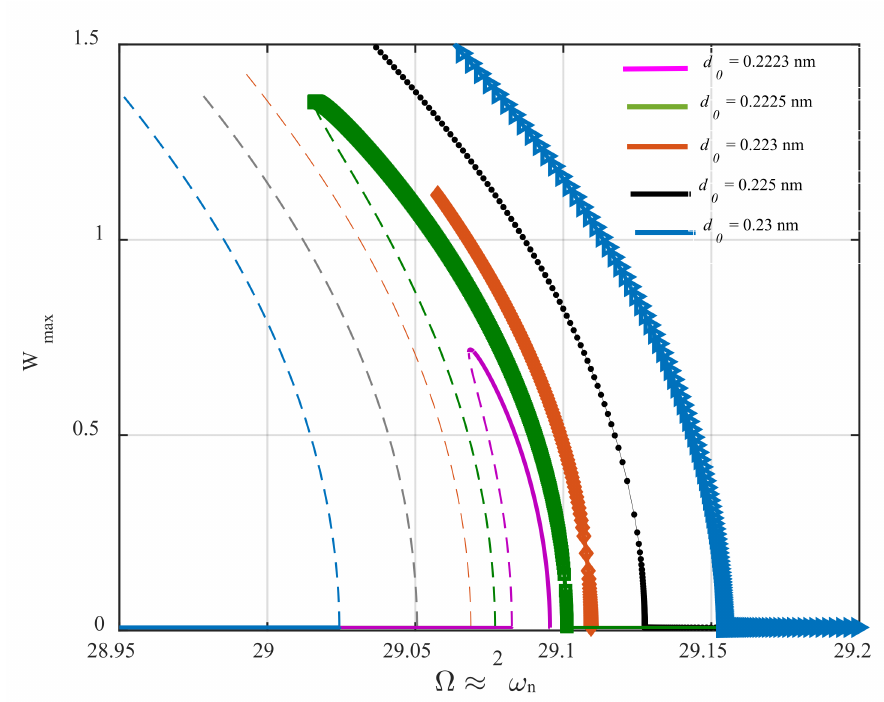
Figure 3. Frequency-response behavior of the AFM in the neighbor of its principal parametric resonance for different values of the base-excitation